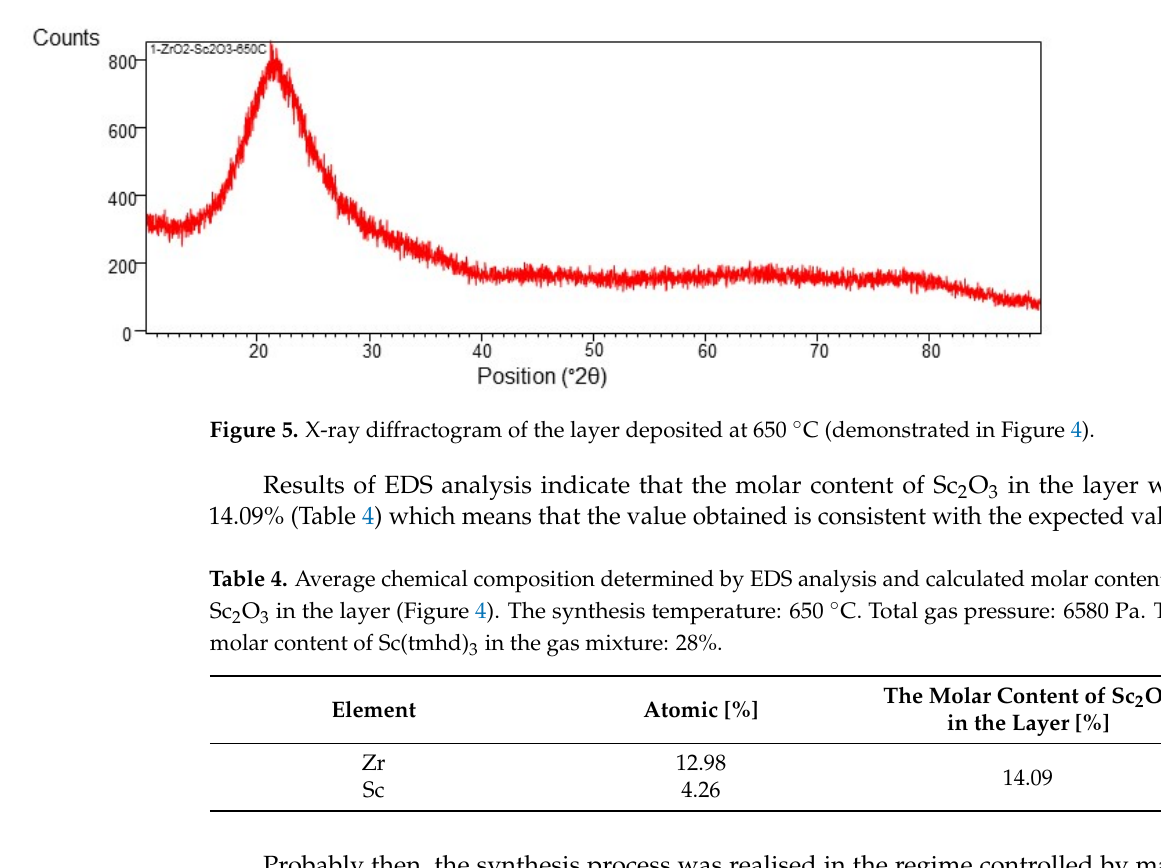
Figure 4. Microstructure of the layer obtained at temperature of 650 °C on tubular substrate at different magnifications: 50,000× (( a ) and 100,000× ( b ) and the cross-section: the layer (bright part)–the substrate (dark part) ( c ). The content of Sc(tmhd) 3 in the gas mixture: 28 mol.%. Total gas pressure: 6580 Pa. Deposition time: 40 min.